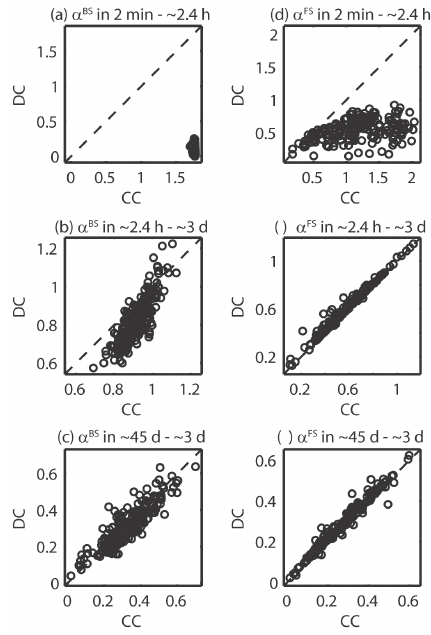
Fig. 9. Scatter plots between the spectral exponents computed for the signals sampled with CC (x-axis) and DC (y-axis) methods. Panels (a) – (c) and (d–f) refer to α BS ( α FS ) for the three scaling